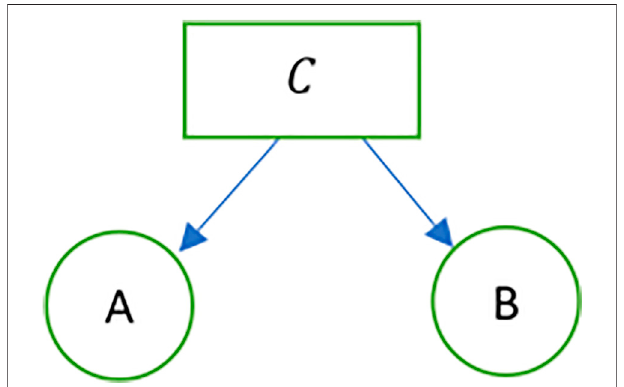
FIGURE 8 | A sheaf representation of transactions.